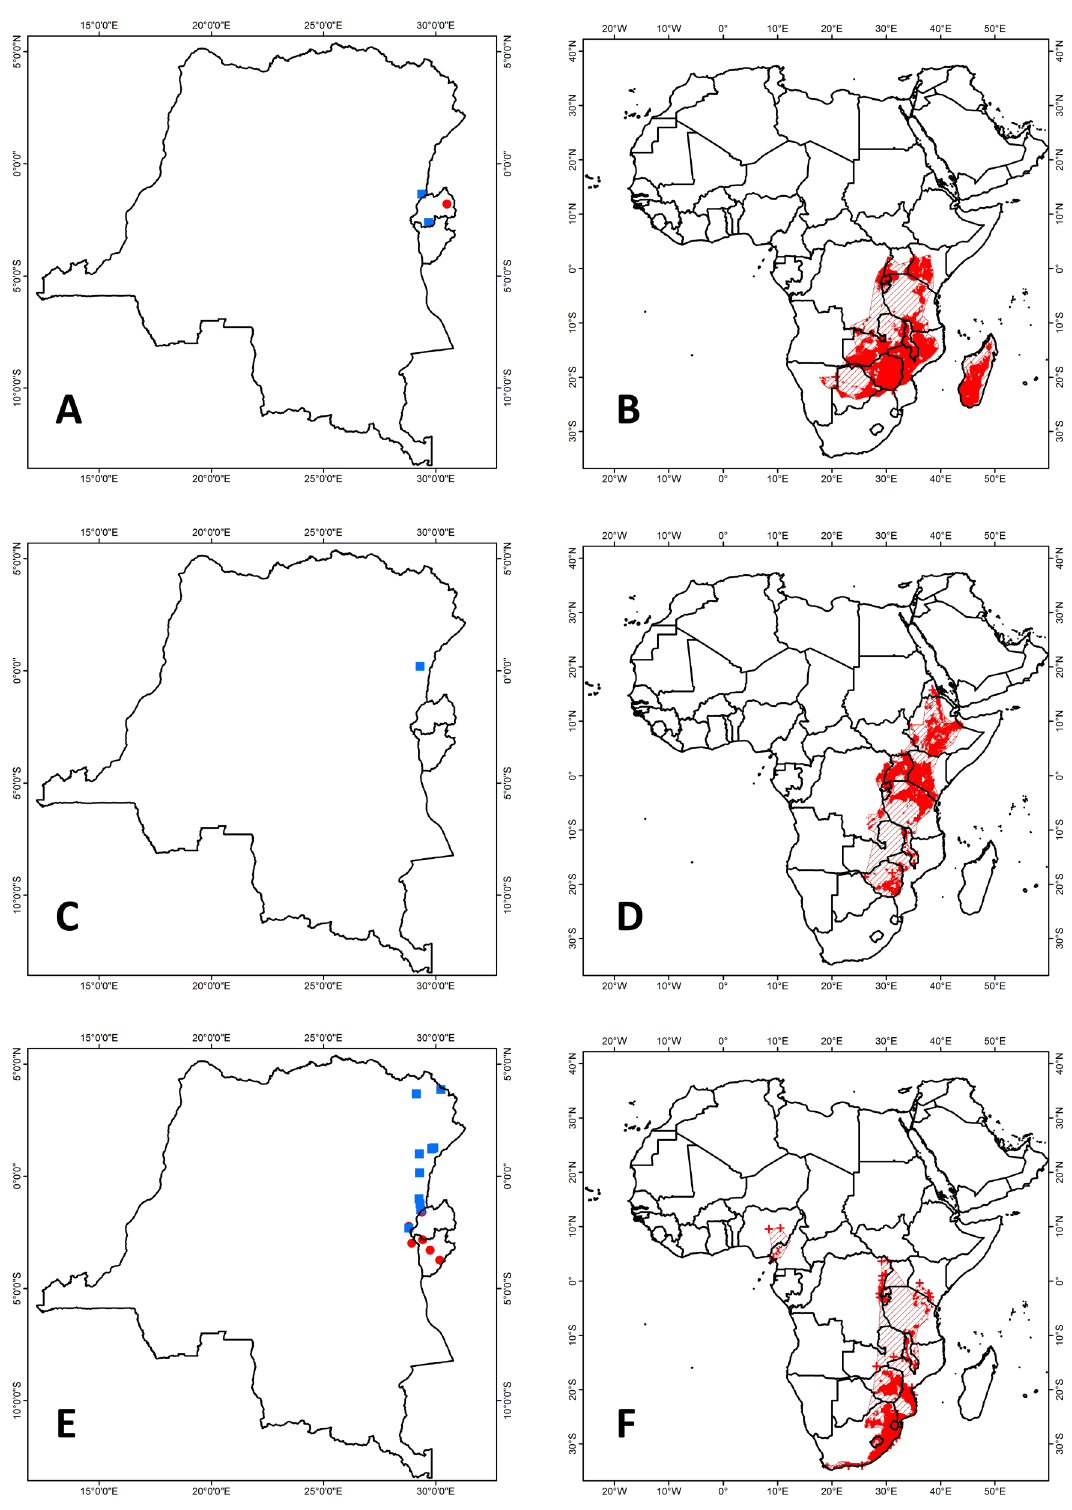
Fig. 32. Distribution maps. A–B . Tadarida fulminans (Thomas, 1903). C–D . Tadarida ventralis (Heuglin, 1861). E–F . Miniopterus fraterculus Thomas & Schwann, 1906. A, C, E. Distribution in